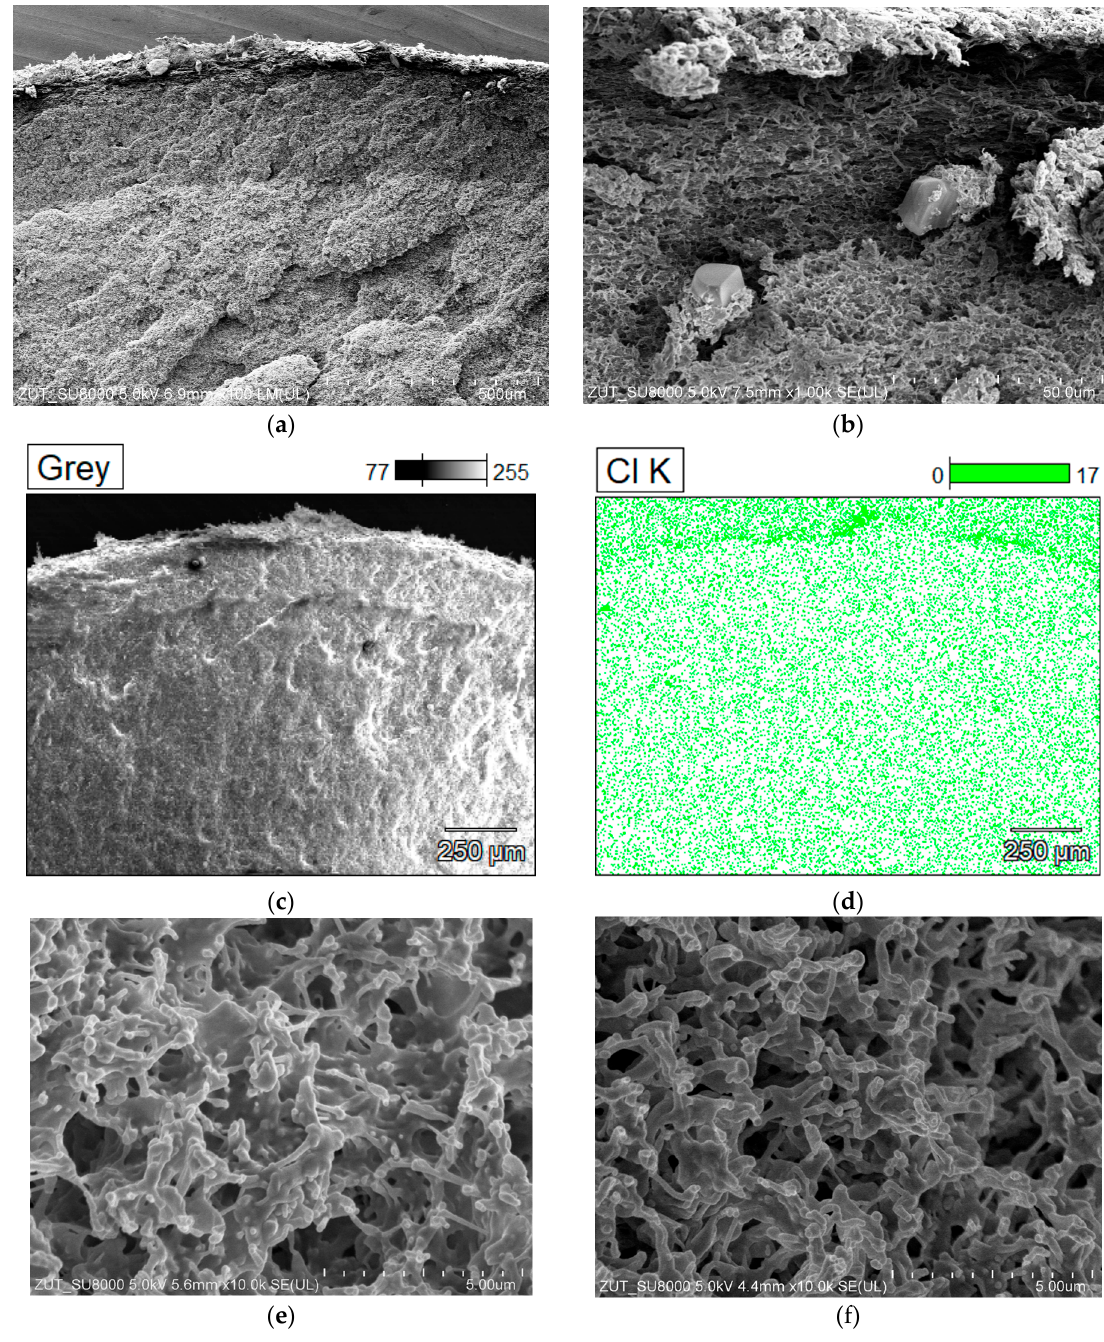
Figure 13. SEM images of V8 membrane cross-sections. ( a ) external edge with “dark ring”, ( b ) magnification external edge- with NaCl crystals, ( c , d ) results of SEM-EDS analysis, ( e ) pores inside “dark ring”, ( f ) pores below “dark ring”.